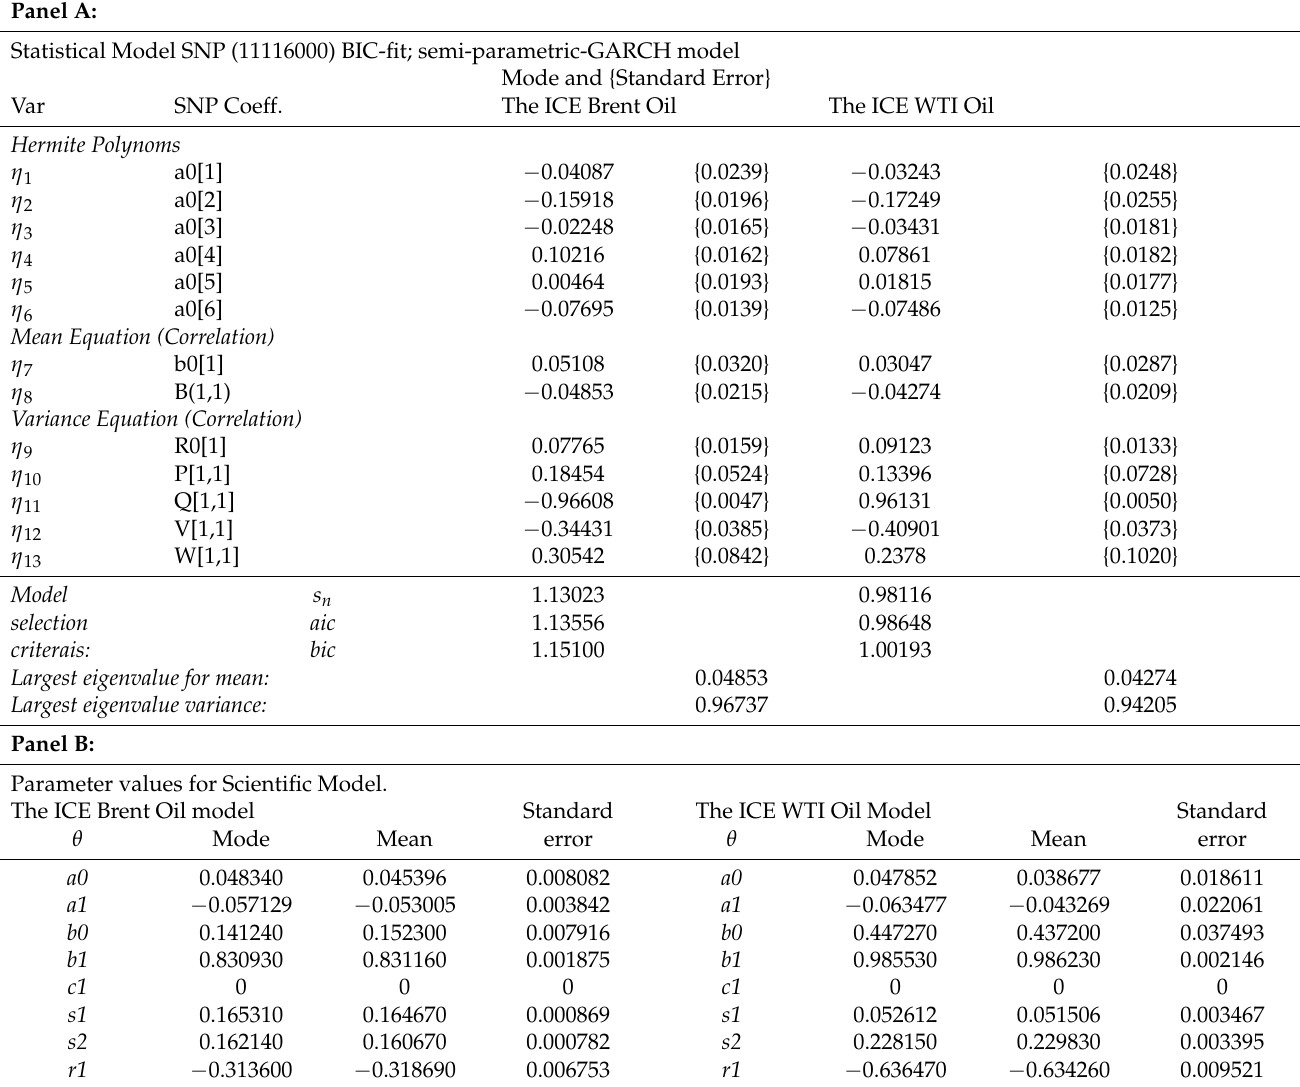
Table 2. Stochastic Volatility Model’s optimal